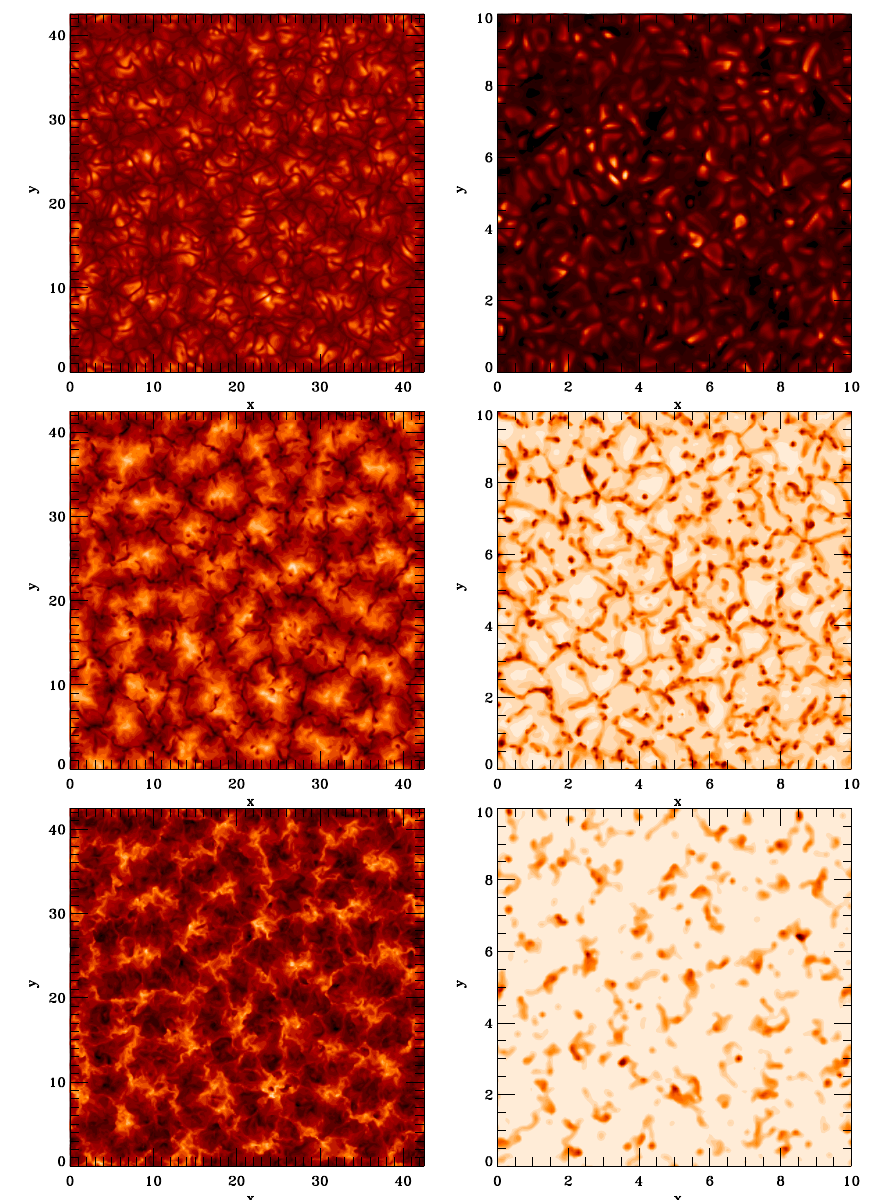
Fig. 12 Comparison between horizontal temperature maps in an idealized simulation of large-scale com- pressible convection in a stratified polytropic atmosphere (left, aspect ratio 42, see Rincon et al. (2005) for details) and horizontal temperature maps in a realistic simulation of large-scale solar-like convection (right, aspect ratio 10, see Rieutord et al. (2002) for details). Top: z = 0 . 99 d and at optical depth τ = 1 respec- tively (surface). Middle: half-depth of the numerical domain. Bottom: bottom of the numerical domain. The emergence of the granulation pattern in the surface layers is clearly visible in both types of simulations, on top of a larger-scale mesoscale dynamics extending down to deeper